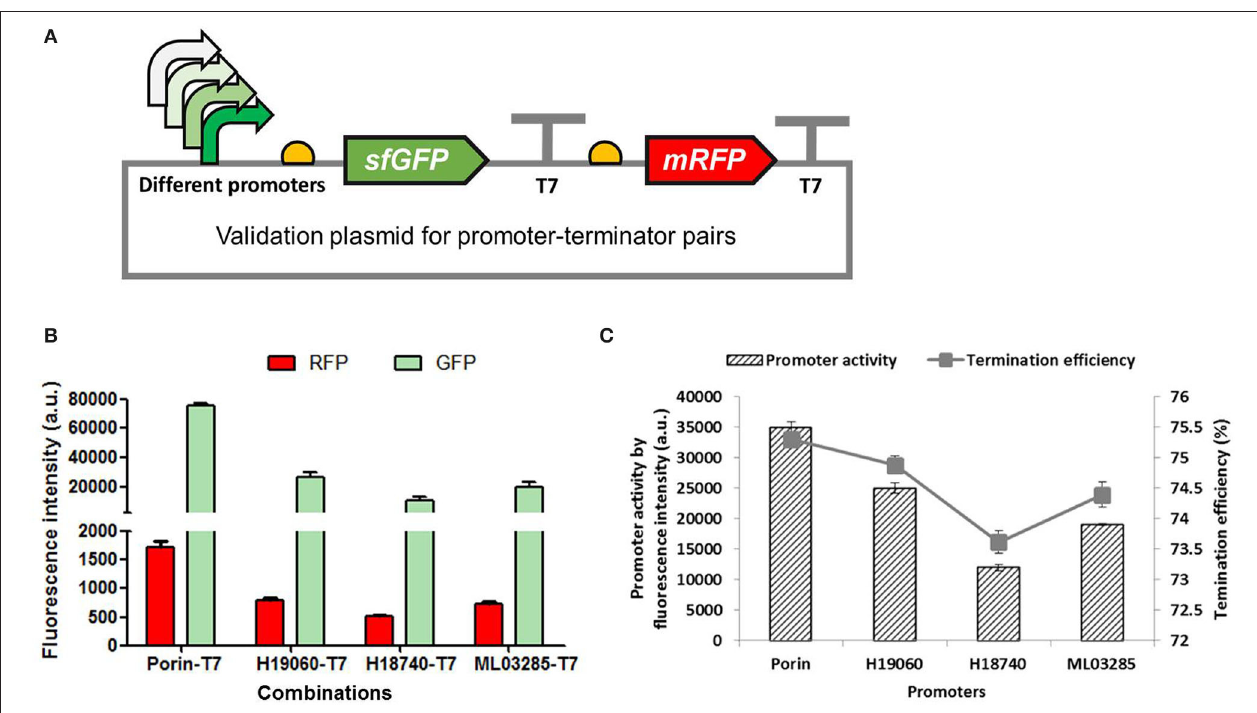
FIGURE 5 | Determination of the effects of promoter activity on the terminator efficiency. (A) Validation plasmids harboring promoters with different activities (Porin, H19060, H18740, and ML03285) to promote the expression of sfGFP and mRFP genes, with the same T7 terminator inserted between the two fluorescent genes. (B) The normalized fluorescence intensities of the GFP and the RFP of the recombinant H. bluephagenesis TD strains harboring different promoter-T7 terminator pairs. (C) The relationship of promoter acitivty and terminator efficiency. The promoter activity was presented by fluorescence intensity of GFP measured in the recombinant H. bluephagenesis TD ( pMCS-P lib -sfGFP ) previously